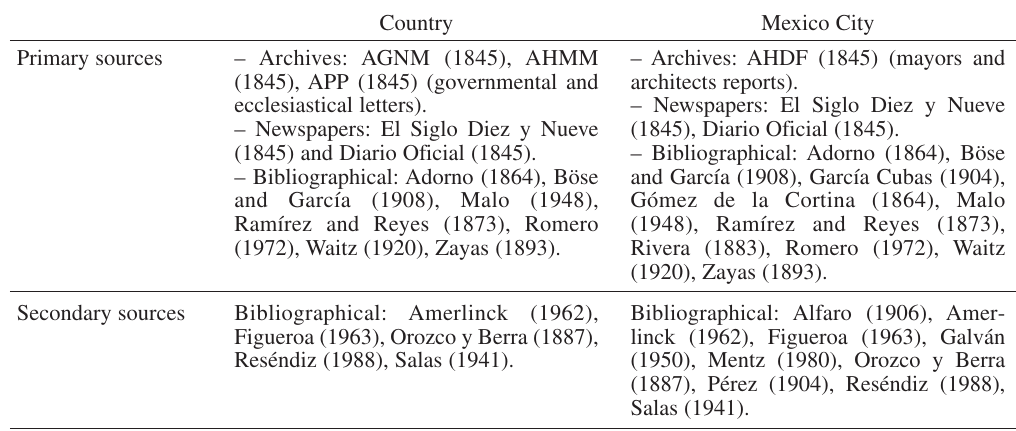
Table III. Sources for the 1845 earthquake.